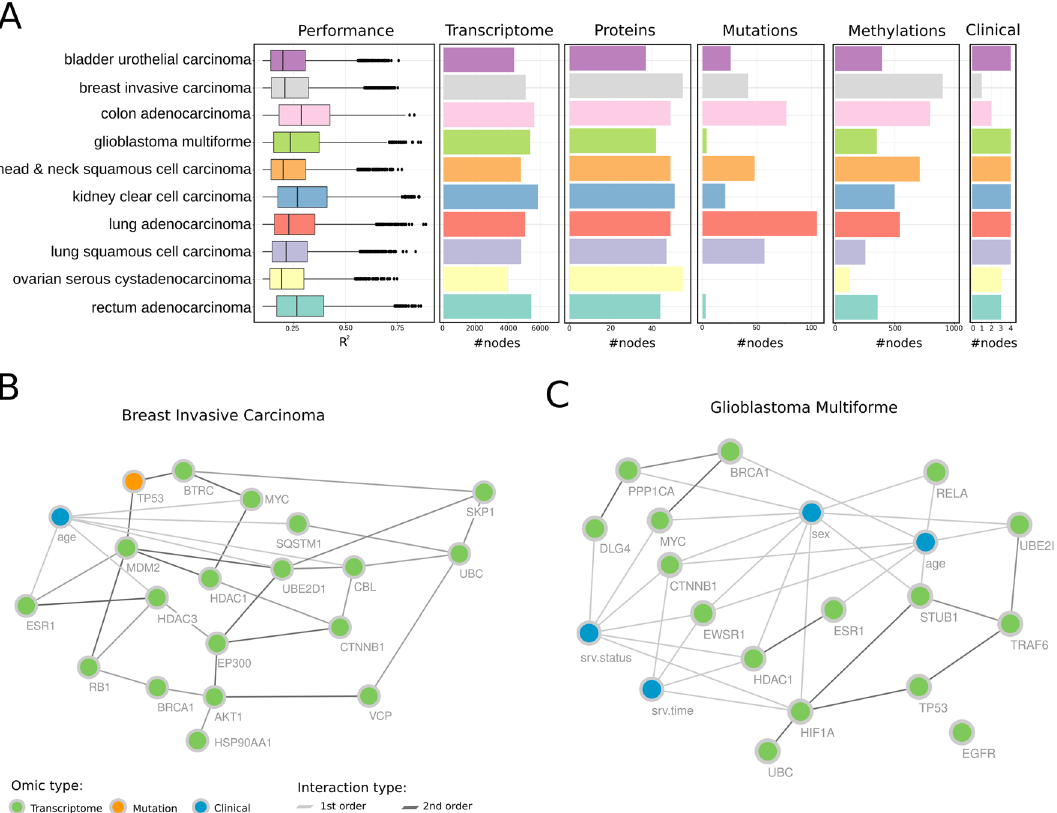
Figure 4. ( A ) Performance on all gene models ( R 2 > 0.1 ) inferred by KiMONo followed by number of gene models and number of features selected in the proteomics, mutation, epigenetic and clinical data layer. ( B ) Subnetwork of top 20 features (highest betweenness of centrality) within the inferred breast invasive carcinoma network ( R 2 = 0.4 ). Within the network, we found nodes originating from mRNA (green), mutation (orange) and clinical (blue) feature space. The edges denote first order edges (grey), first and second-order (black). ( C ) Subnetwork of the top 20 features in Glioblastoma Multiforme ( R 2 = 0.4